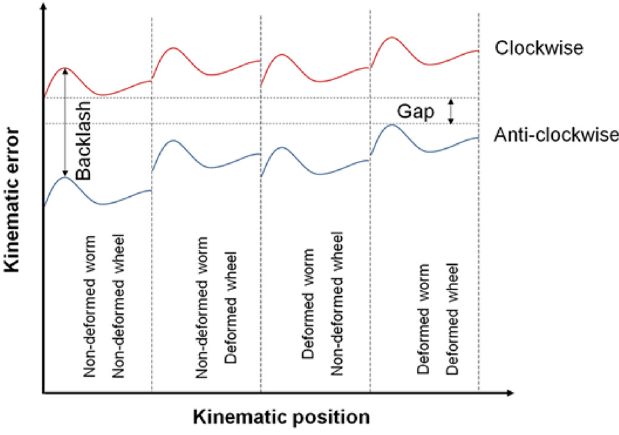
Fig. 8. Comparison between positive backlash and positive gap (properly aligned kinematic